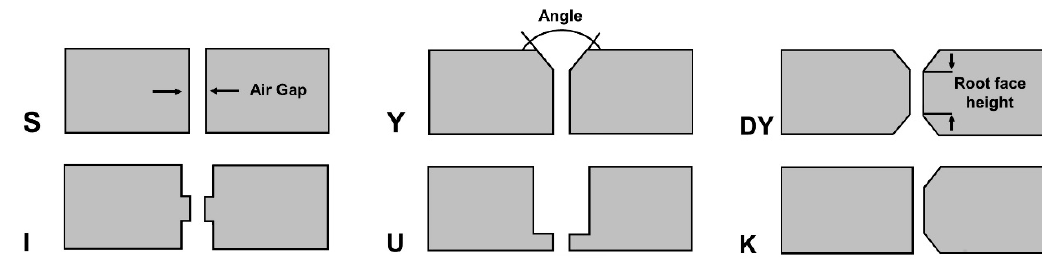
Figure 11. Groove designs in hybrid welding process. Table 10. Joints configuration of hybrid welding